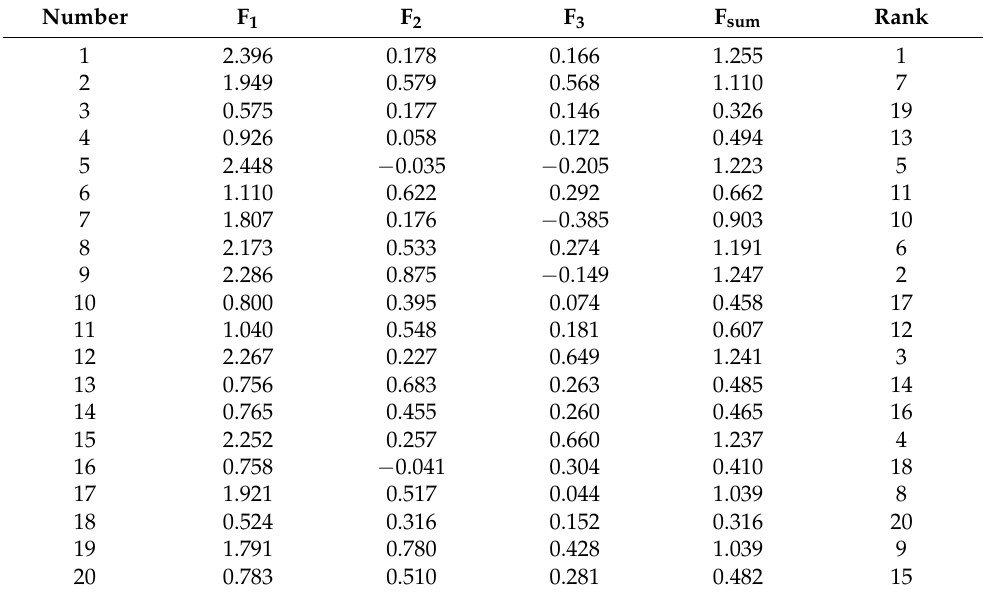
Table 6. Health status prediction and evaluation results of